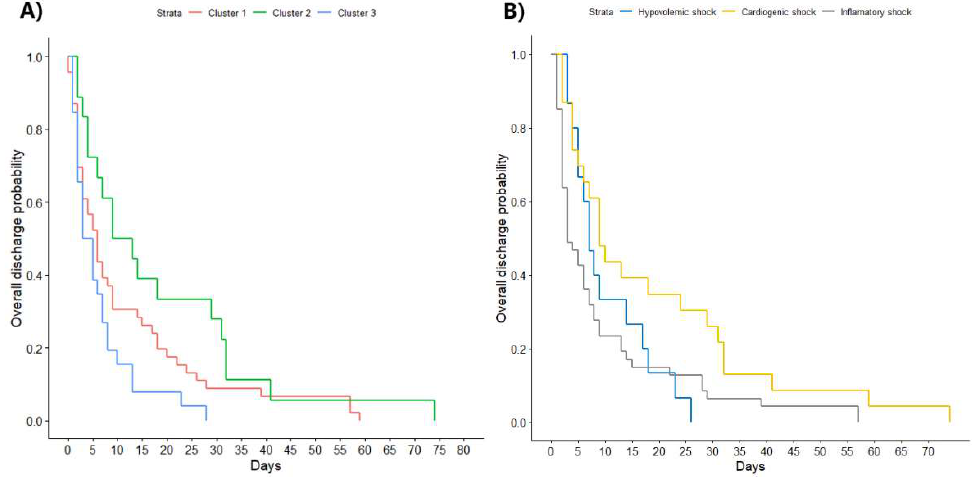
Figure 3. Kaplan–Meier curves for the length of stay in the intensive care unit ( A ) according to clus- ters and ( B ) according to classic classification. clusters and ( B ) according to classic